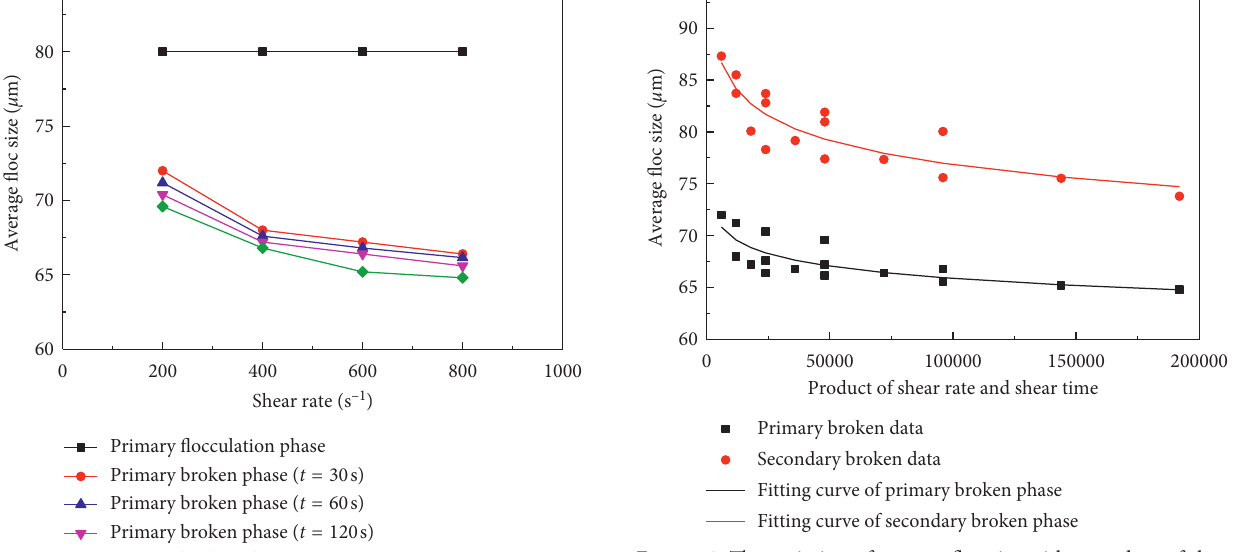
Figure 8: The variation of average floc size with a product of shear rate and shear time in the primary and secondary broken